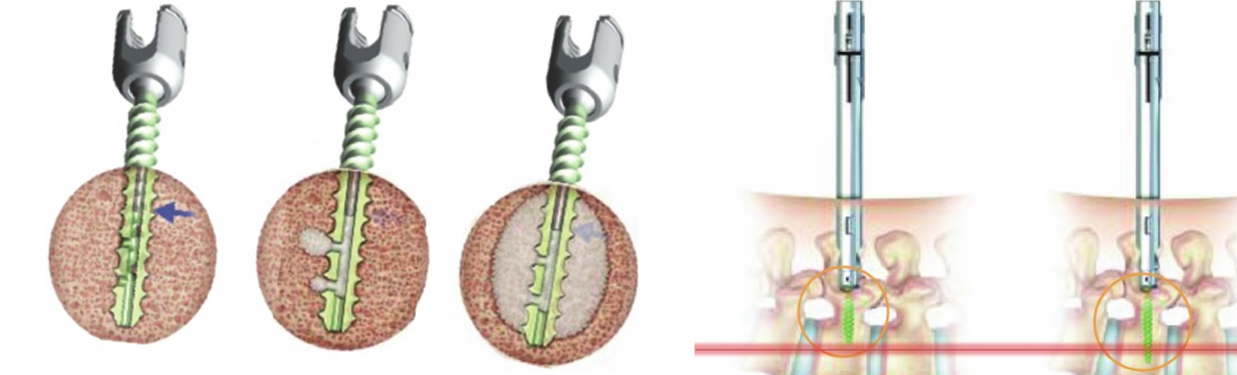
Figure 3: When fenestrated screw is placed through the percu- taneous or miniopen approach, the length of screw is important because of the risk of extravasation of PMMA bone cement. An optimal alignment with the pedicle is recommended. Position of the holes must be located as far as possible from the posterior